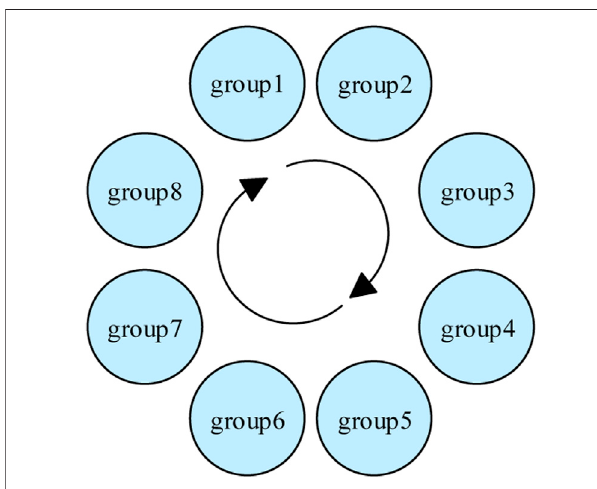
FIGURE 4 | Permutation between states in eight groups is allowed in a clockwise.